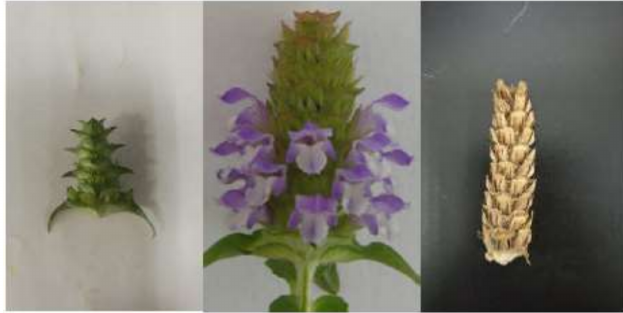
Figure 2. Spica development periods of P. vulgaris (from left to right: stage 1: bud stage, tage 2: full-flowering stage, and stage 3: mature-fruiting